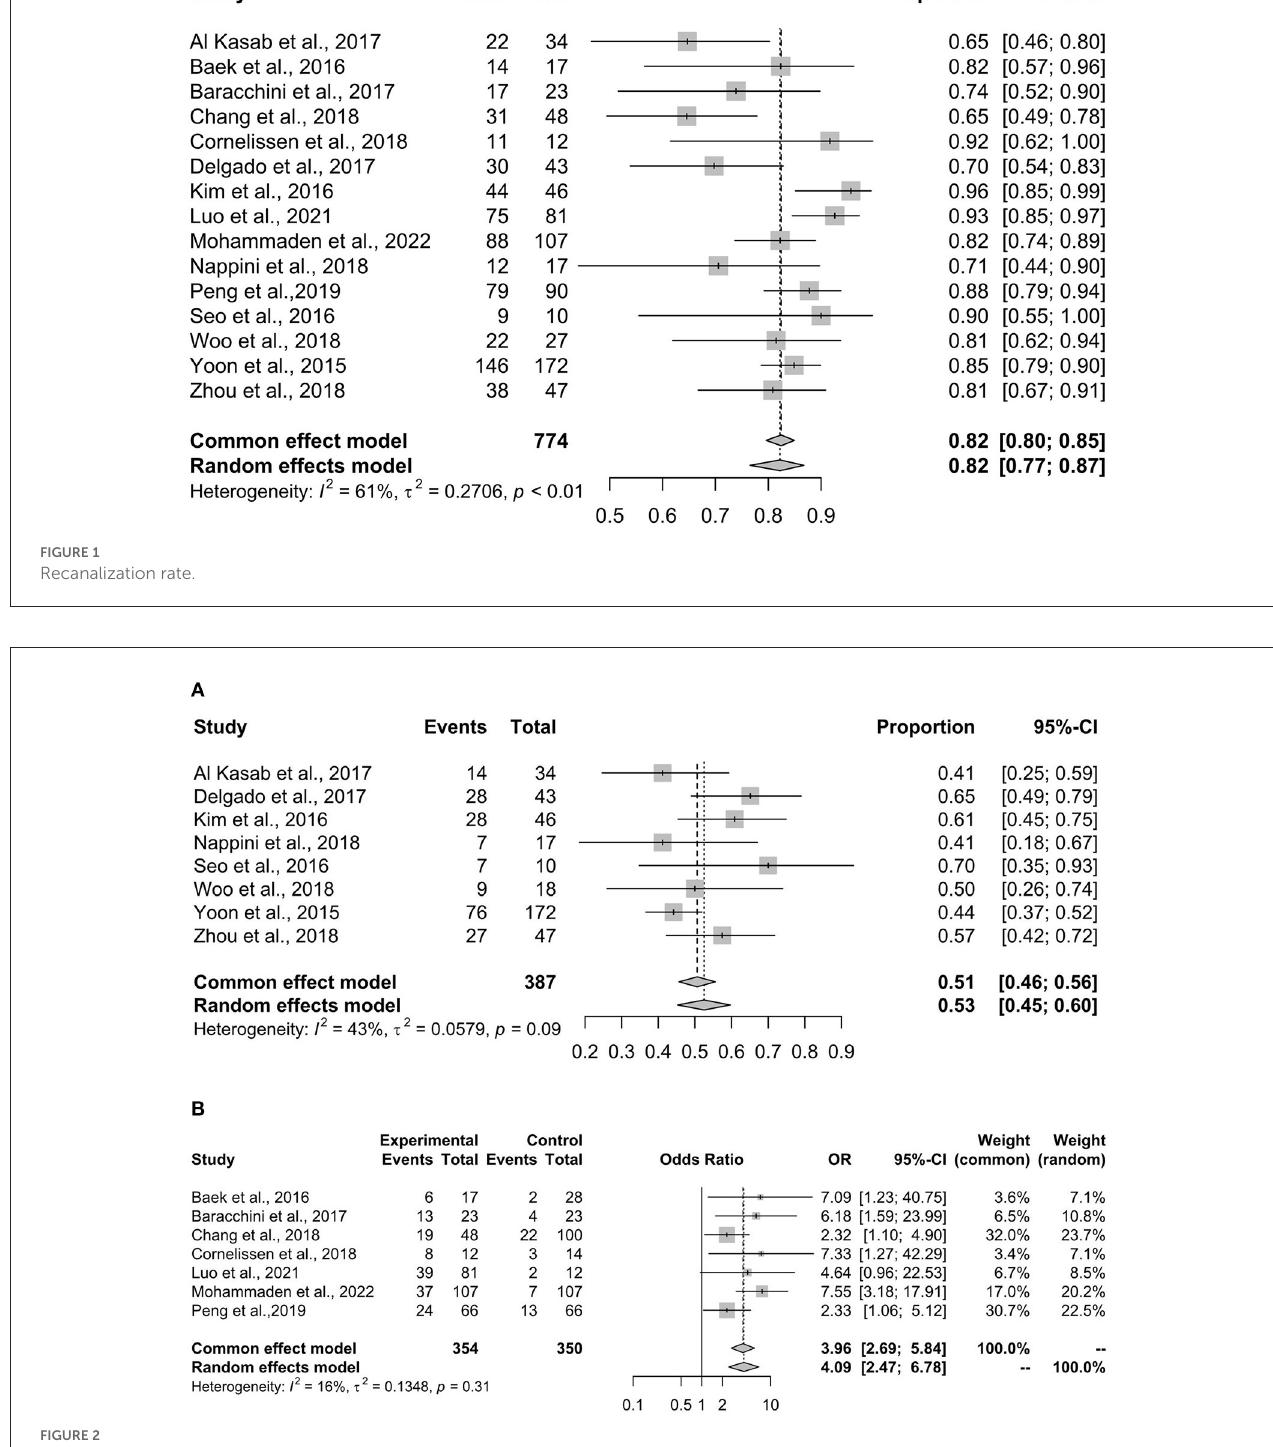
FIGURE2 The mRS score assessment. The mRS score of 0–2 indicates a good outcome of patients with ischemia stroke. (A) Summarizes the proportion of patients with 0–2 mRS scores, using data from cohorts without control groups. (B) Shows the comparison of stenting vs. non-stenting in the proportion of patients with 0–2 mRS score, and a higher OR indicates a better result of the stenting arm. mRS, modified Rankin Scale; OR, odds